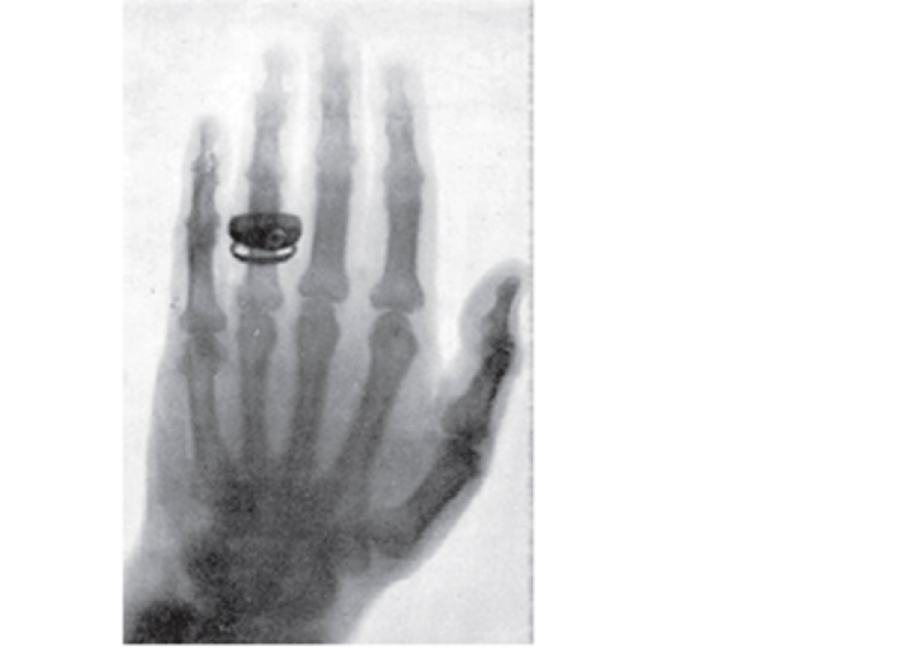
Figure 1. First X-ray picture made in public by Roentgen during his first oral presentation before the Würzburg Physico-Medical Society on 23 January 1896. The picture shows the hand of Albert Kolliker who chaired the talk.